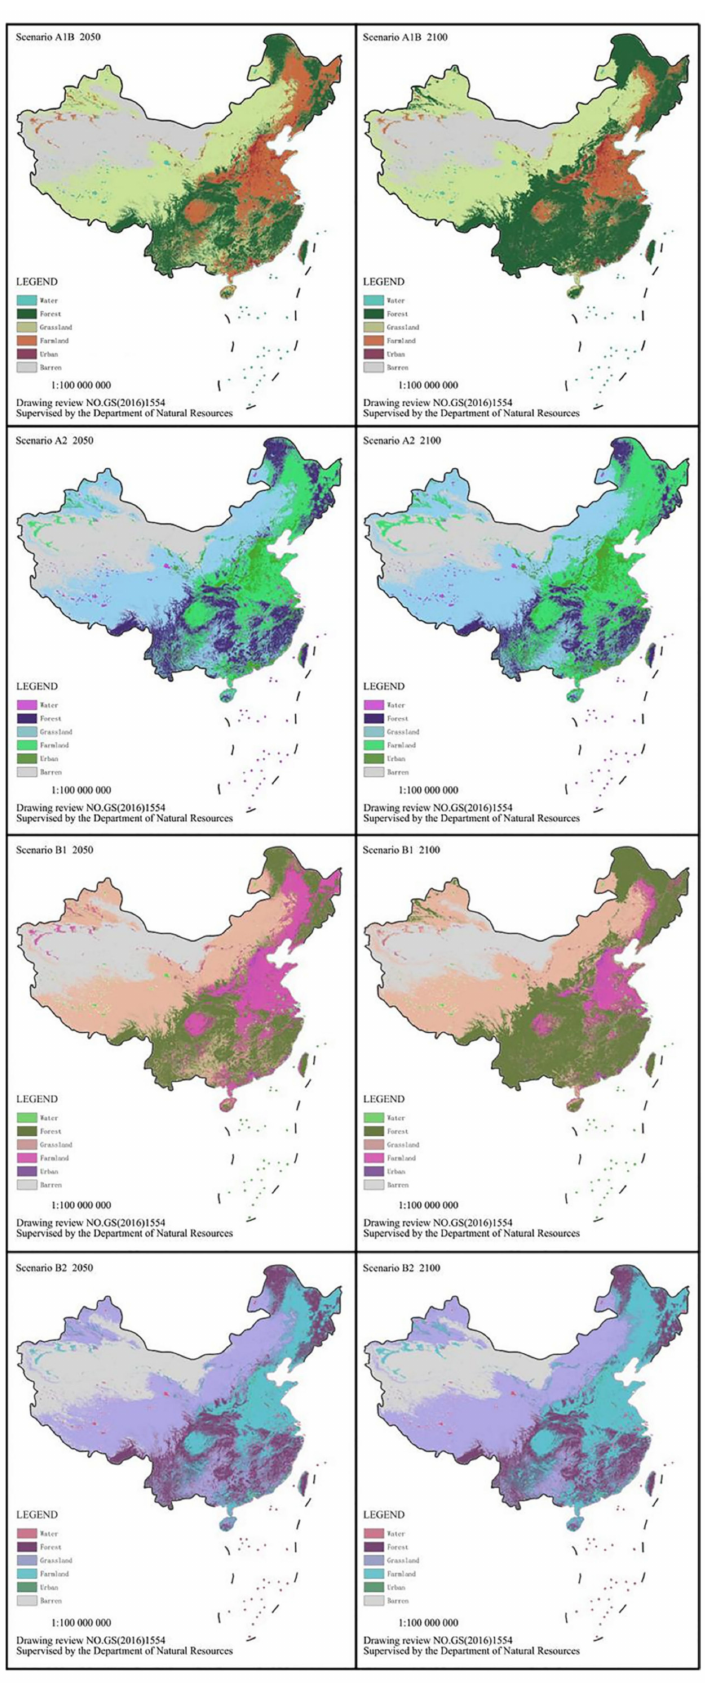
Figure 5. China’s land use distribution in different scenarios (with no modification to base